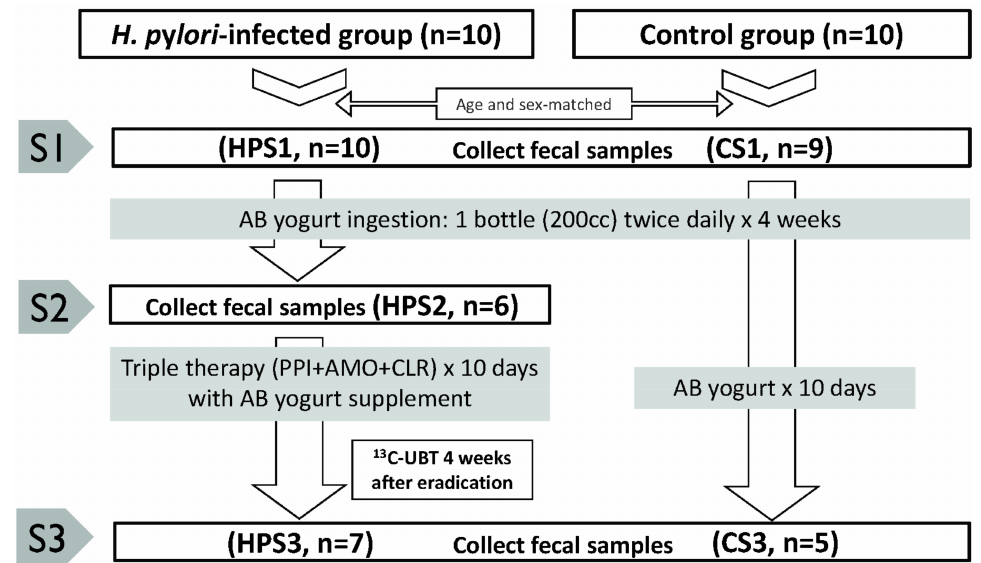
Figure 1. The numbers of subjects and fecal samples at enrollment, on the 4th week, and 4 weeks after triple eradication therapy. CS1: non- H. pylori infected controls at enrollment; CS3: non- H. pylori infected controls 4 weeks after yogurt ingestion; HPS1: H. pylori -infected children at enrollment; HPS2: H. pylori -infected children after 4 weeks of yogurt ingestion; HPS3: H. pylori -infected children 4 weeks after eradication